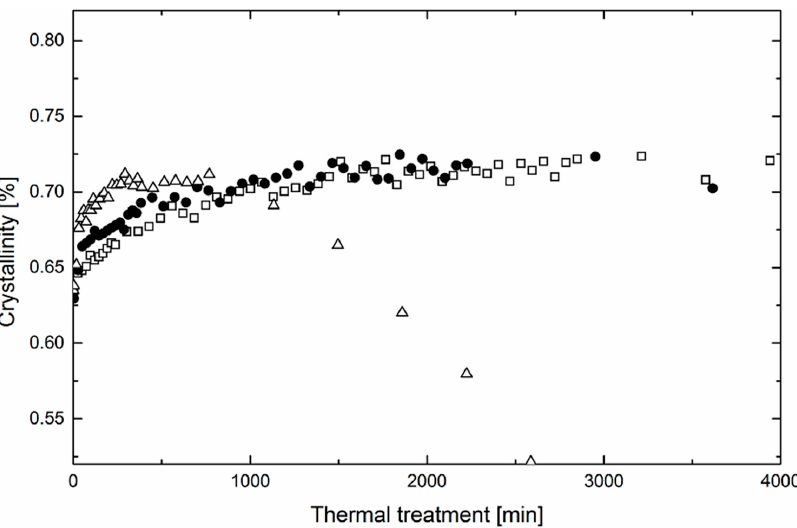
Figure 5. Evolution of crystalline structure of nanofibrous webs prepared from water/PEO solution at three different temperatures in time (squares denote 40 °C, circles 50 °C, and triangles 60 °C).